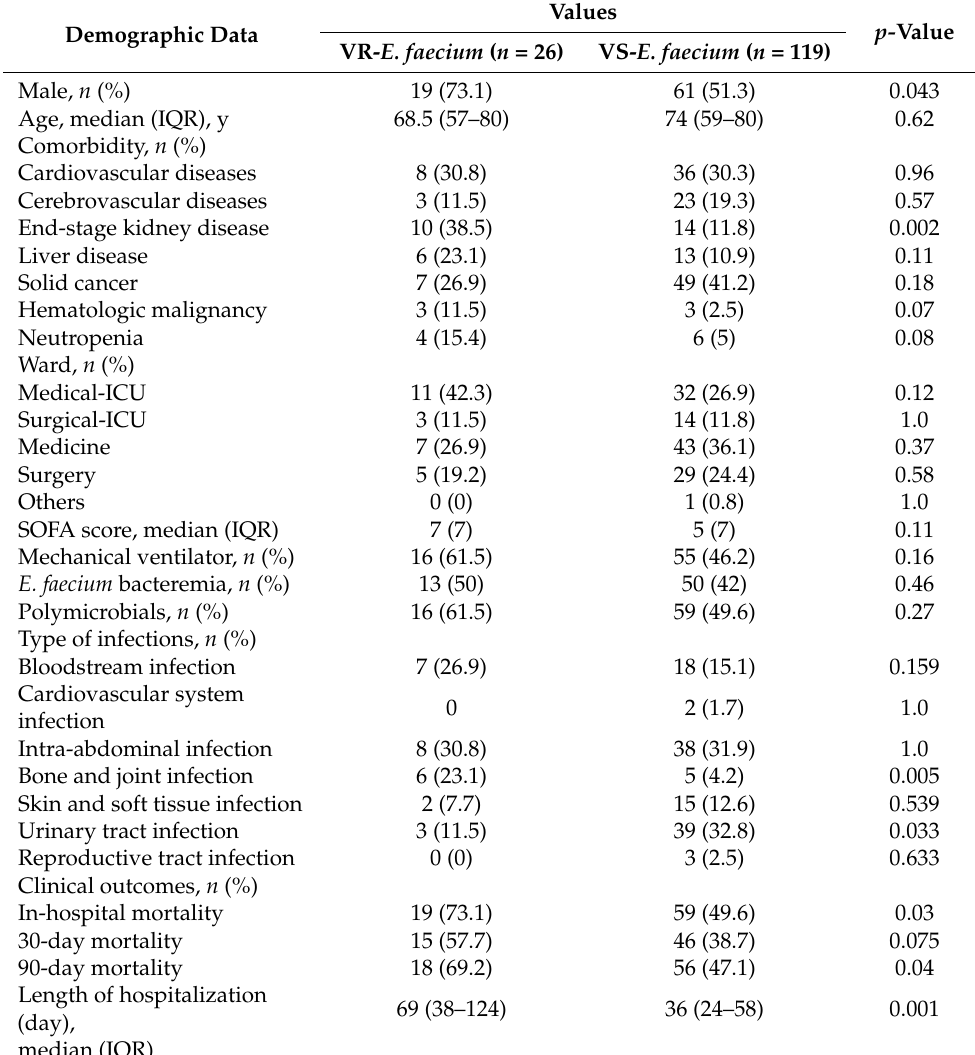
Table 1. Characteristics and clinical outcomes of patients infected with VR- E. faecium and VS- E. faecium